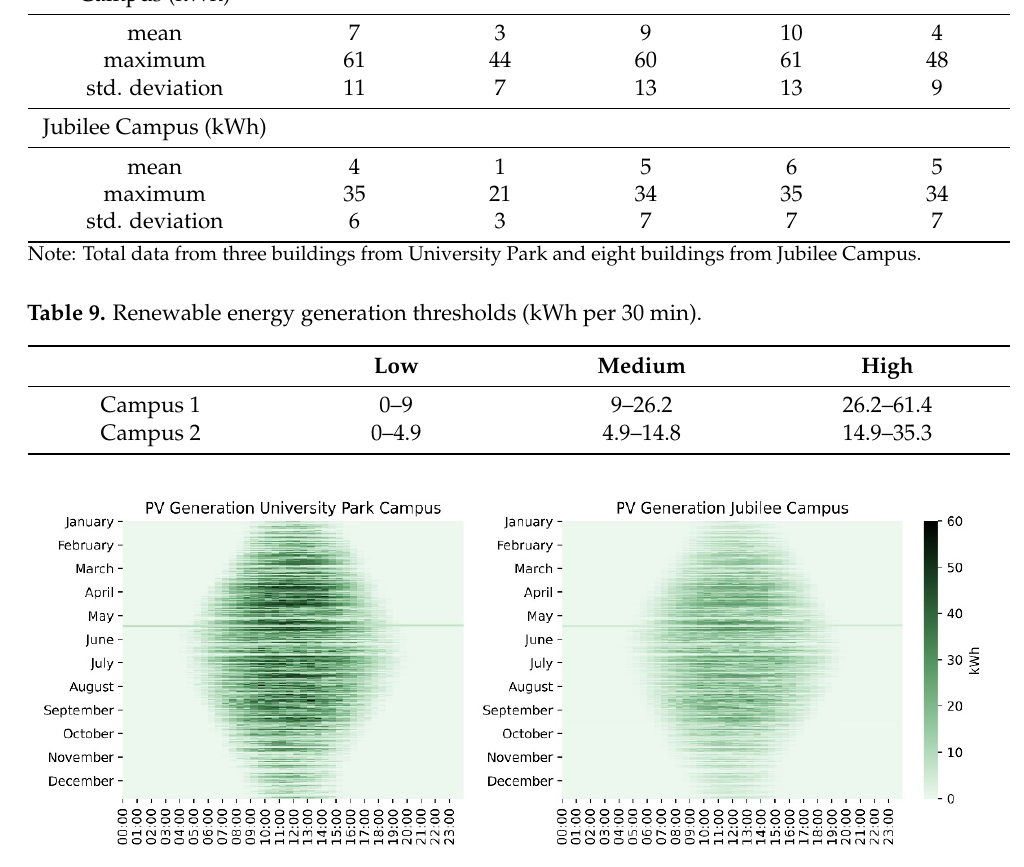
Table 9. Renewable energy generation thresholds (kWh per 30 min).